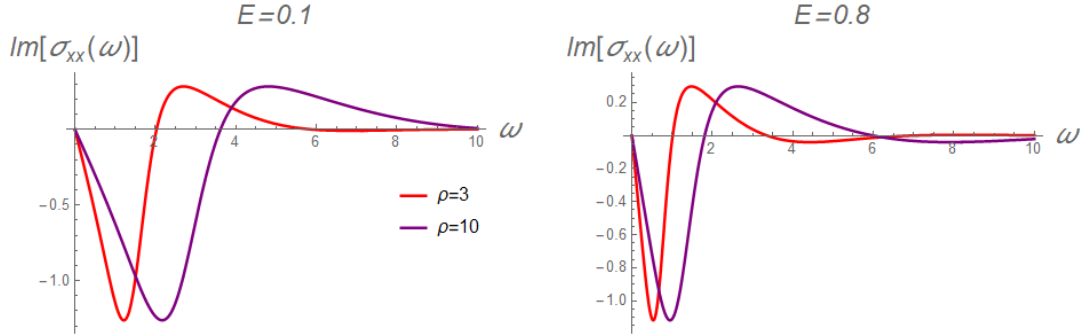
Figure 6 . Imaginary part of the longitudinal (cid:27) xx conductivity for the case E < B (symmetric